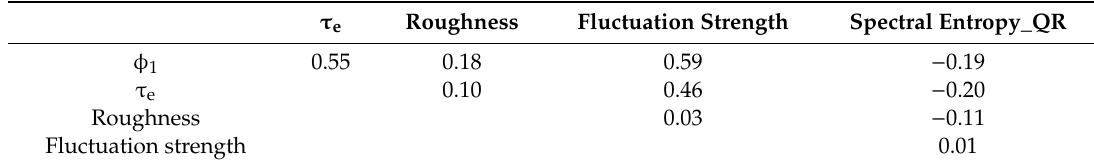
Table 5. The correlation coe ffi cients between the explanatory variables used in the multiple regression analysis in the equal loudness condition for insect